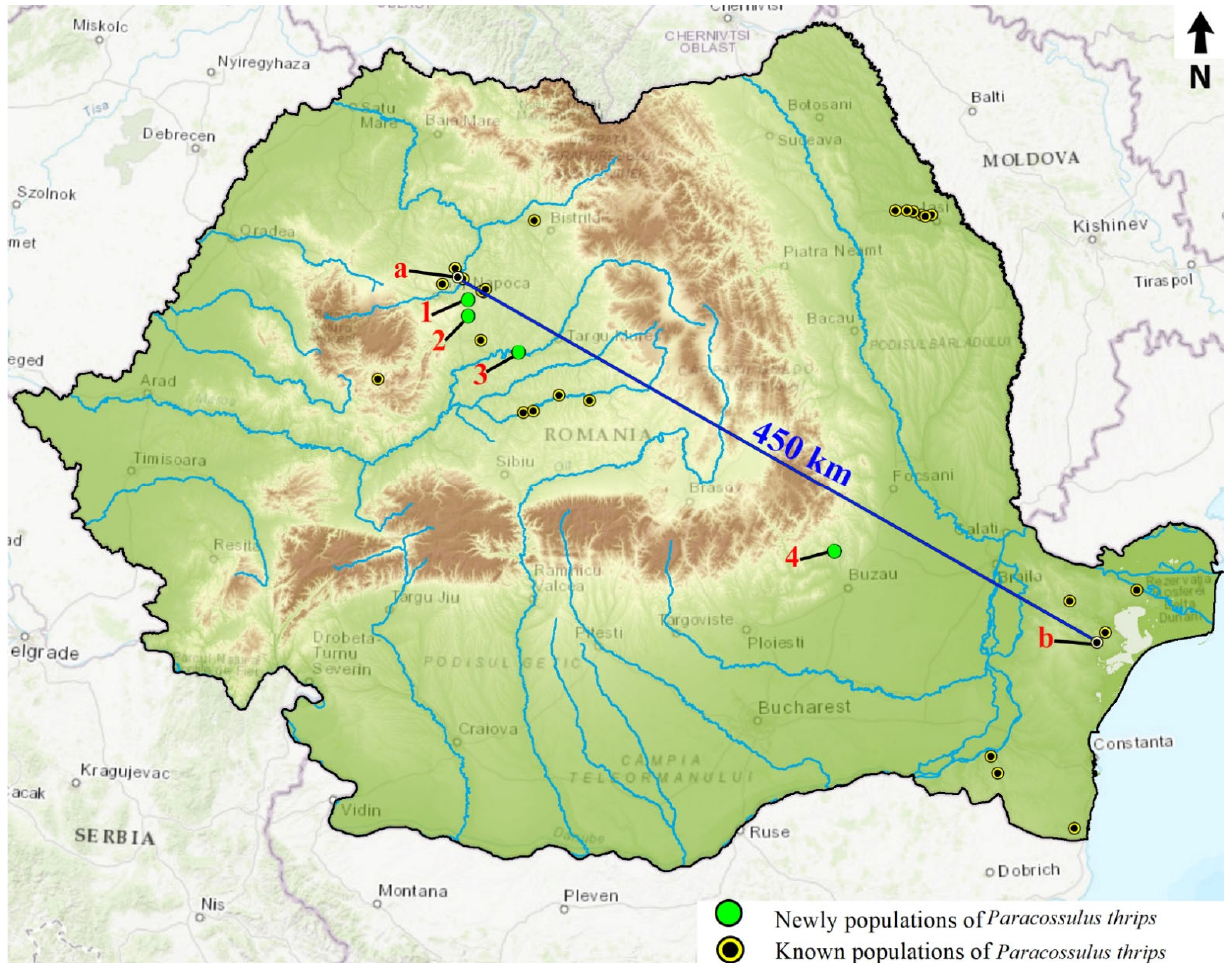
Figure 1. Distribution of Paracossulus thrips populations in Romania. Green dots represent newly populations: 1 —population from Cojocna; 2 —population from Ploscos, 3 —population from Râpa Lechin ș a; 4—population from Vulcanii Noroio ș i; Black dots represent known population; The two locations for sequences sampling: ( a )—Jucu de Sus; ( b )—Babadag, a also indicate the studied area.